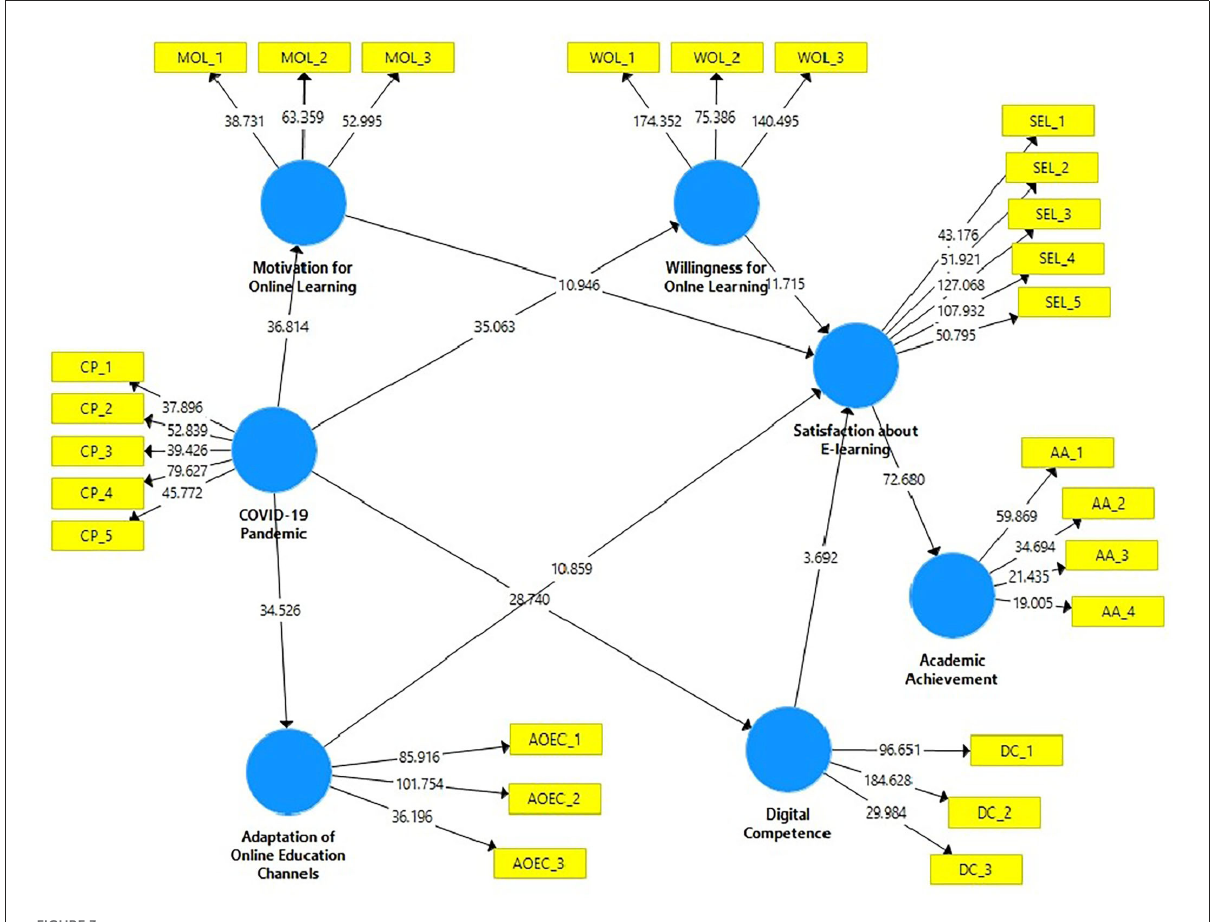
FIGURE3 PLS-Bootstrapping, T